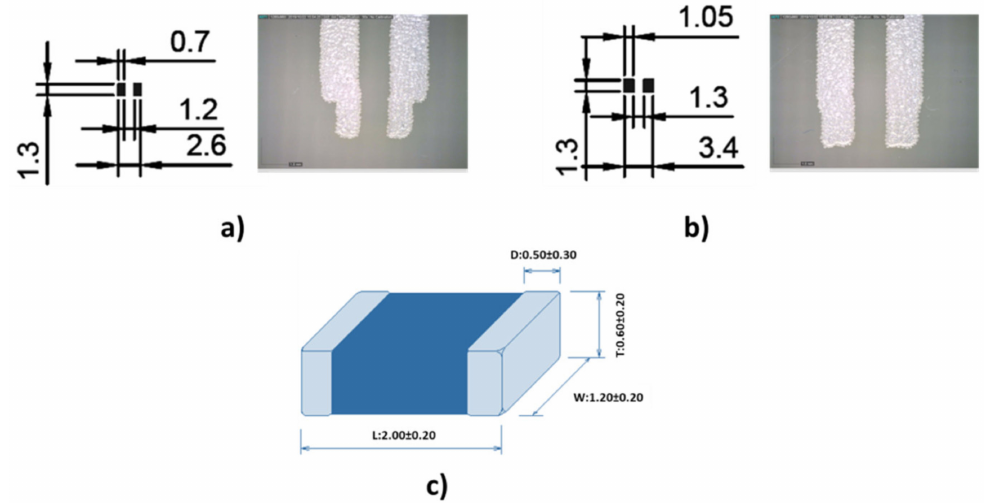
Figure 12. ( a ) The 0805 solder reflow footprint, ( b ) the 0805 wave solder footprint and ( c ) the 0805 package